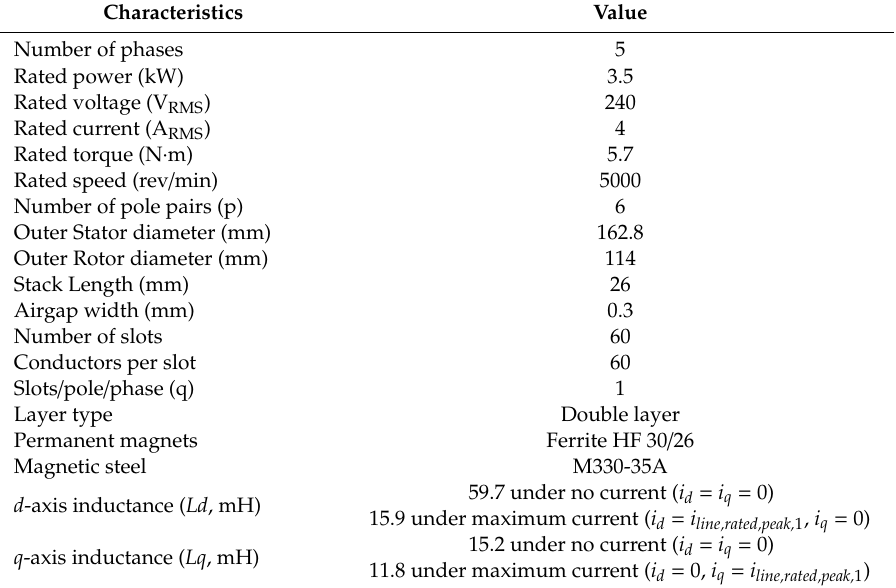
Table 1. Characteristics of the ferrite-permanent magnet-assisted synchronous reluctance motors (fPMa-SynRM) analyzed in this